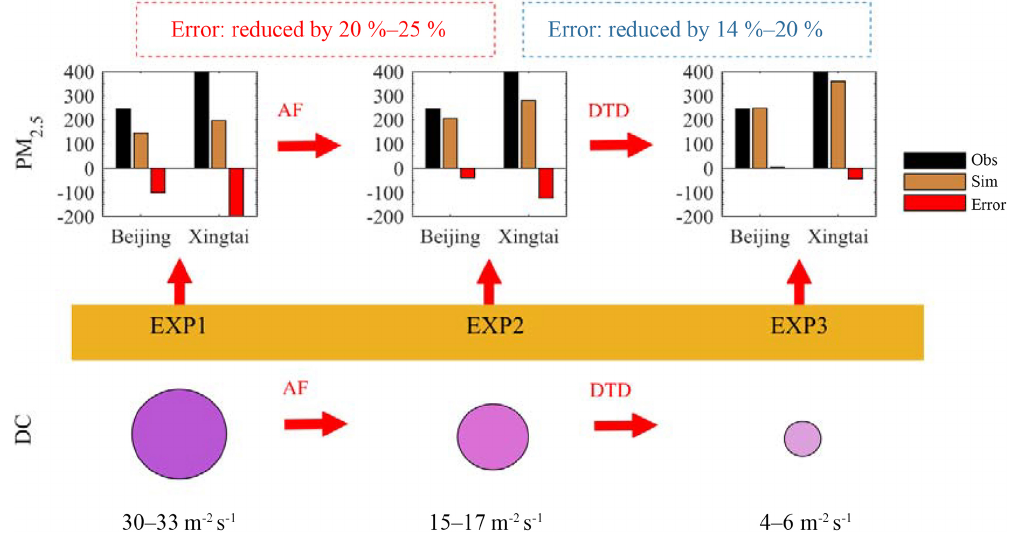
Figure 9. Diagrammatic sketch of the contributions of the AF and the decrease in the turbulent diffusion coefficient (DTD) to the PM 2 . 5 explosive